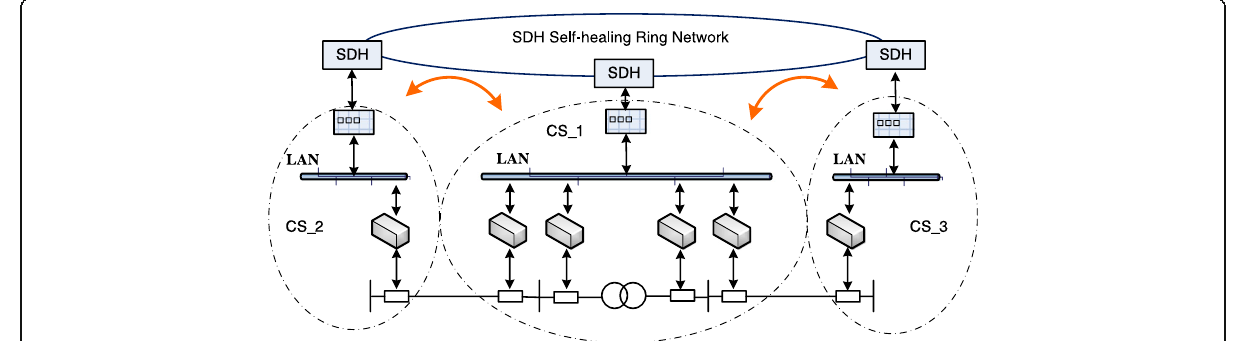
Fig. 2 Communication mode of adjacent